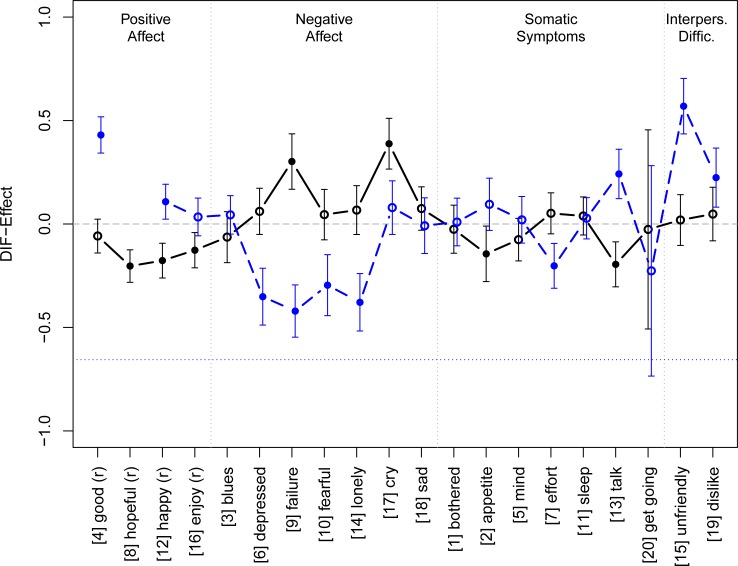
Differential item functioning due to gender and depression.Notes: The dots represent the DIF-Effect, i.e., the item parameter difference between the two groups; error bars indicate the 95% confidence interval; Bullets indicate a significant DIF-Effect for the respective item. Values below 0 means that the item is rather preferred by men, items with DIF-values above 0 are rather preferred by women. The solid line indicates DIF according to sex and the dashed line indicates DIF according to depression. In the latter case, item 2 had to be omitted due to technical reasons (see text). For better readability, the two curves were horizontally displaced.